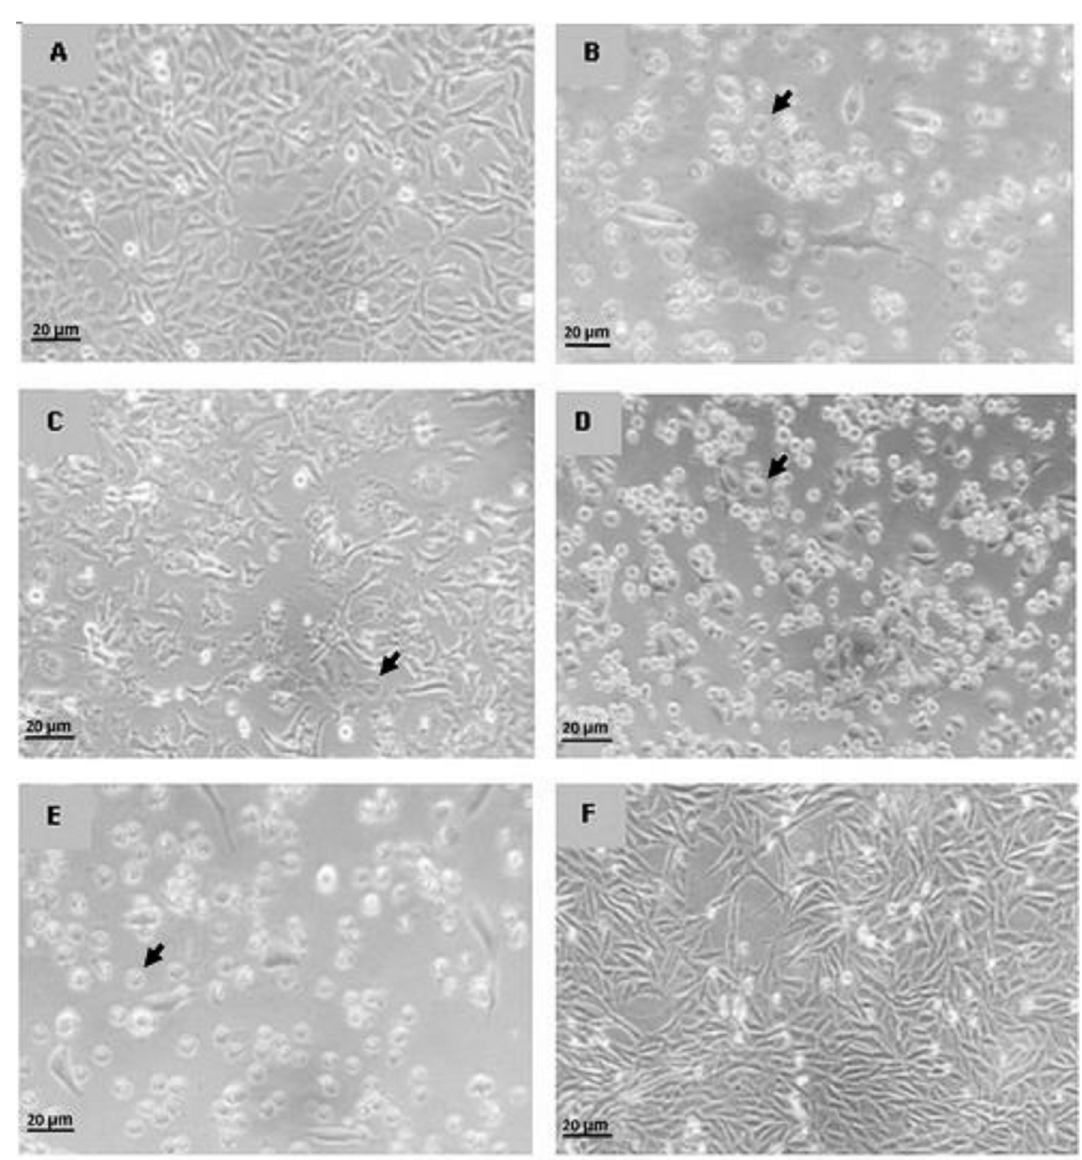
Figure 2. Cell morphology of breast cancer T47D cells after treatment with extracts of Ancorina sp. Control ( A ), Methanol ( B ), Dichloromethane:Methanol ( C ), Dichloromethane ( D ), Doxorubicin ( E ) and DMSO ( F ). Observation of cell morphology was performed using inverted microscope Axio Vert.A1 Zeiss with a magnification of 40x. Arrow shows dead